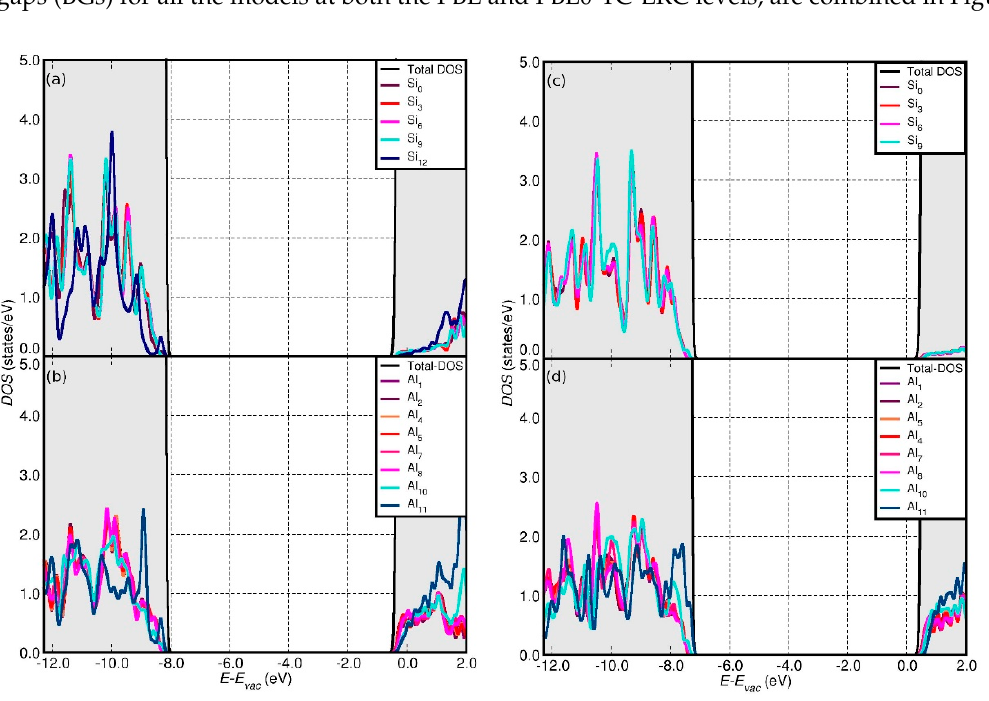
Figure 4. Calculated (vacuum-aligned) total density of states (DOS), together with the Al and Si ring resolved (Figure 1) local density of states (LDOS) for the OH- ( a,b ) and H 2 O- ( c,d ) terminated AlSi hex-7 model.